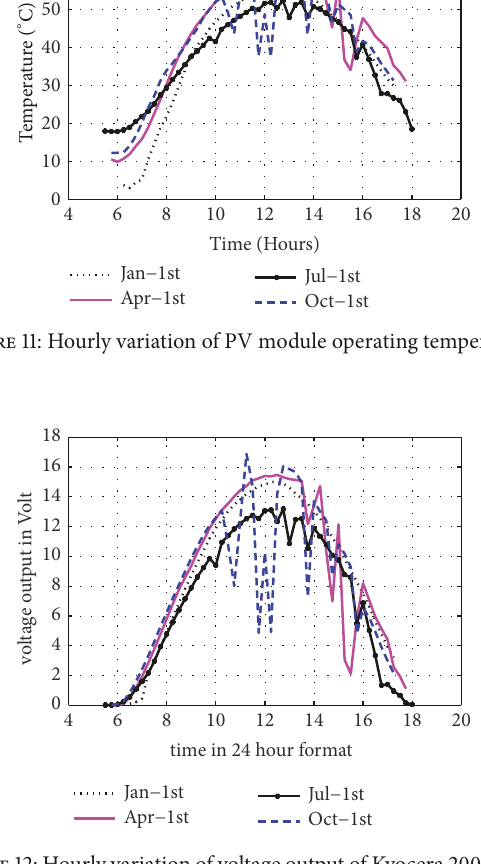
Figure 12: Hourly variation of voltage output of Kyocera 200GT PV module for 2 Ω